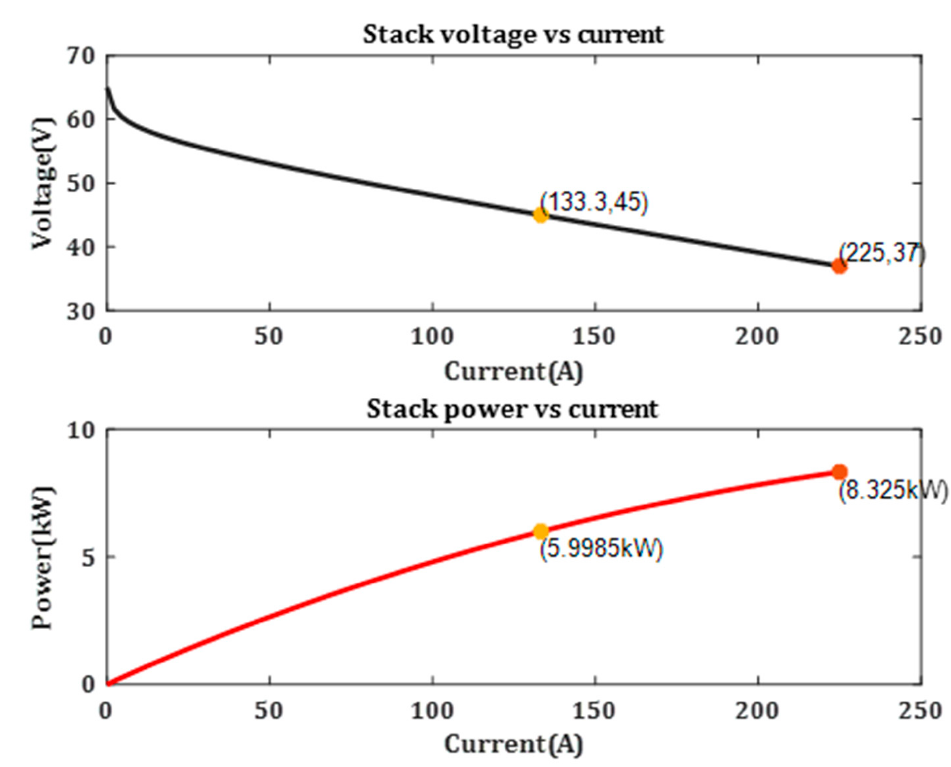
Figure 2. Stack voltage versus current, and power versus current [7].